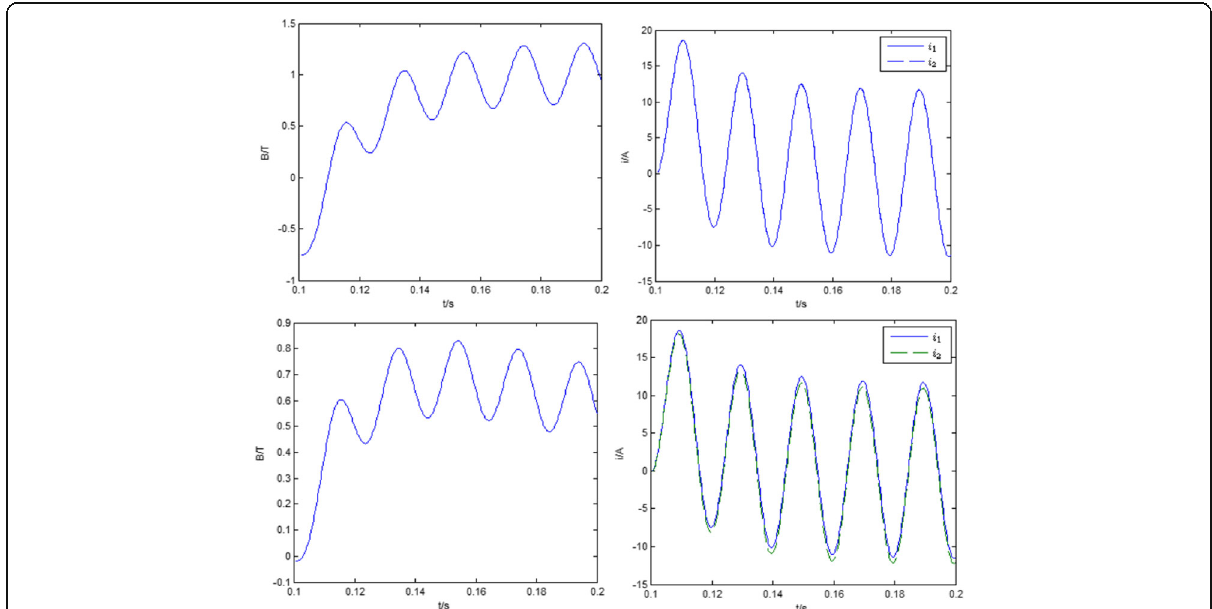
Fig. 16 -50% remanence, magnetic flux generated at fault occurring time is